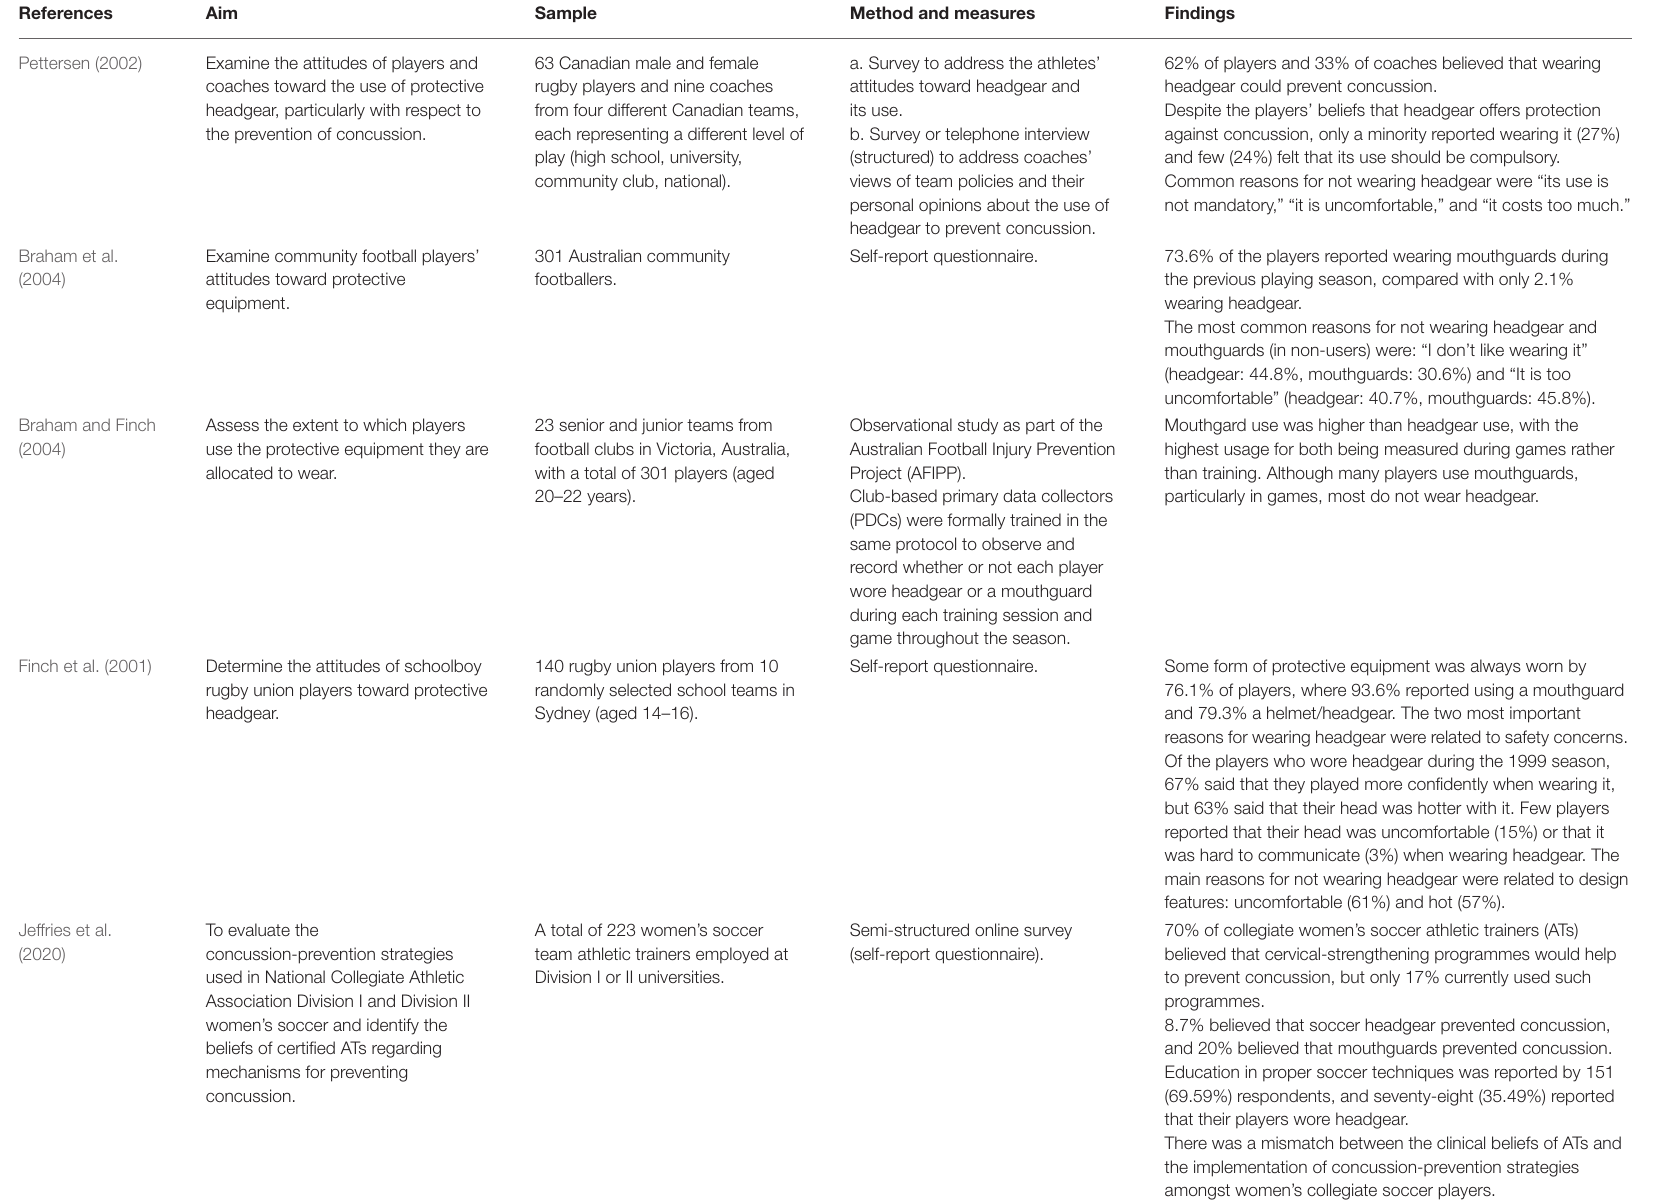
TABLE 3 | Results of the scoping